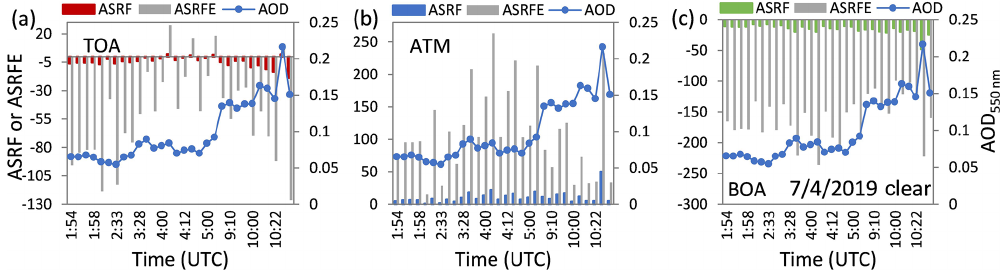
Figure 6. Instantaneous aerosol solar radiative forcing and efficiencies of the clear-sky case on 7 April 2019 at the Kashi site: (a) TOA, (b) ATM, and (c) BOA.